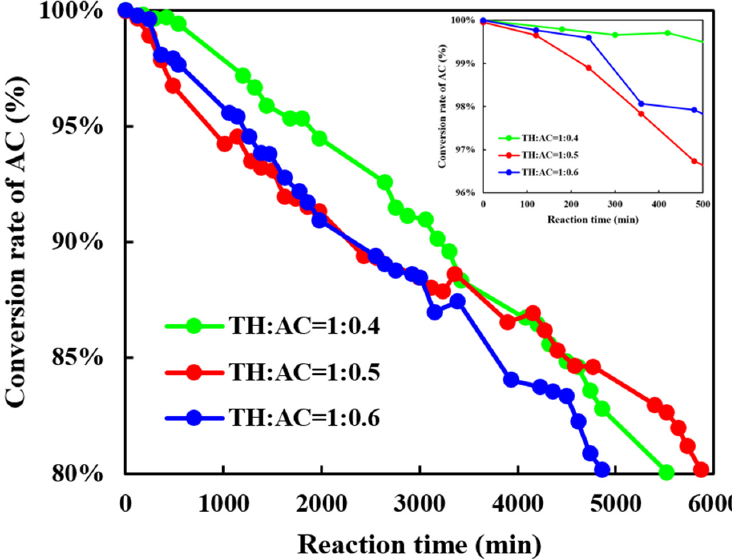
Figure 3. The influence of the molar ratio on the continuous acylation of thiophene.